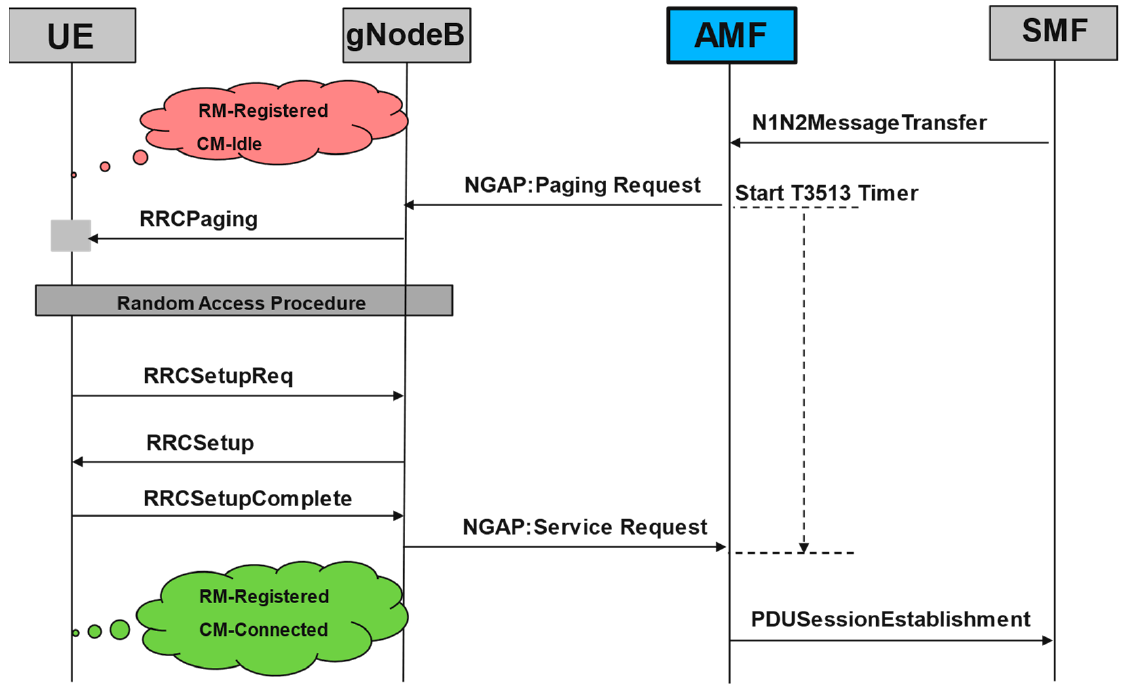
Figure 2. Flow of 5G network-initiated paging.